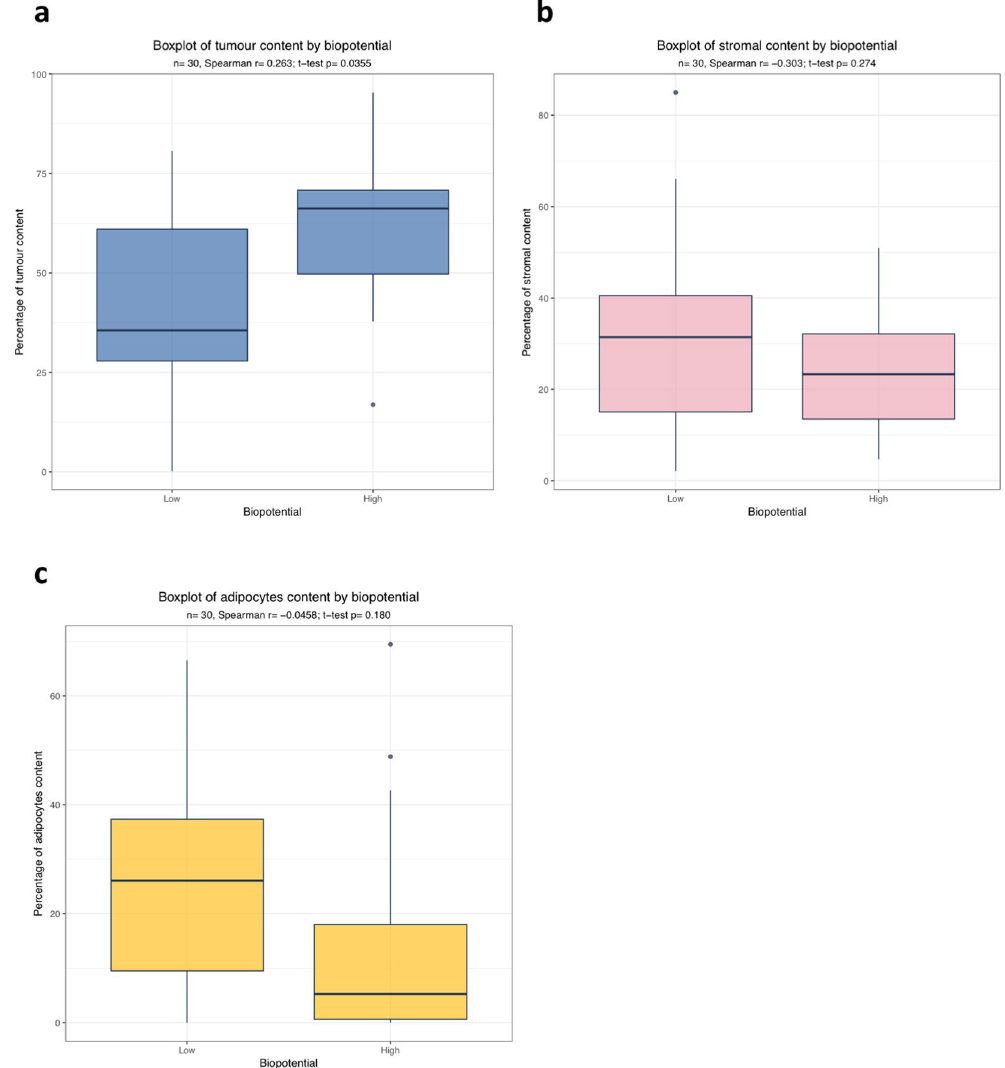
Figure 3. Potential biological correlations with biopotential readings in advanced ovarian cancer. Three different sites in the cancerous omentum from ten EOC cases were analysed. ( a ) Box plot representing the positive correlation between tumour content and biopotential levels, stratified at normalized median biopotential levels into low (below the median) versus high (above the median). High biopotential levels significantly correlated with increased tumour load (p = 0.0355) ( b ) Box plot showing that increased stromal content negatively correlates with low biopotential. ( c ) Adipocytes content and biopotential showed a trend with increased adipocyte load correlating with low biopotential. The correlations were measured by Spearman’s correlation coefficient and